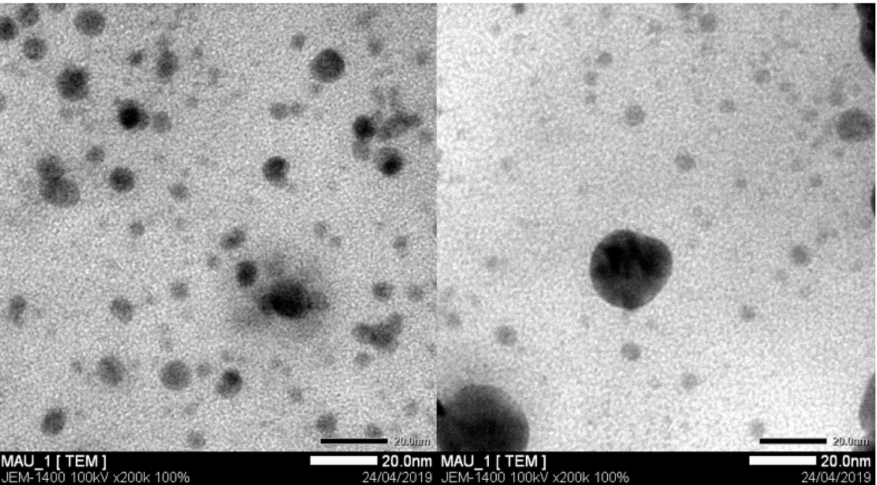
Figure 4. TEM images of the AgNPs produced under incubation in process B with 1 mM AgNO 3 .